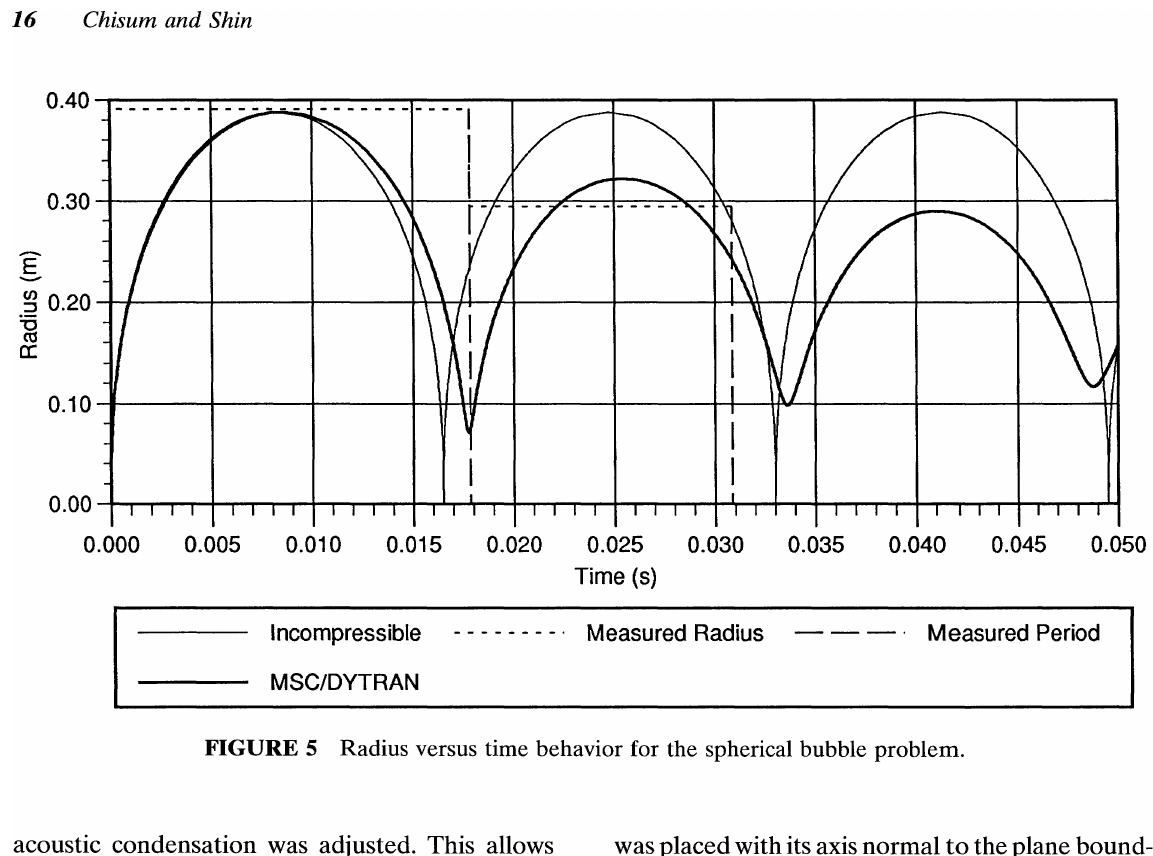
FIGURE 5 Radius versus time behavior for the spherical bubble